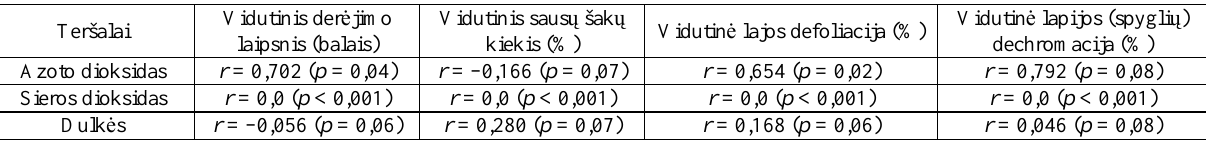
Vidutin ė lapijos (spygli ų ) dechromacija (%)